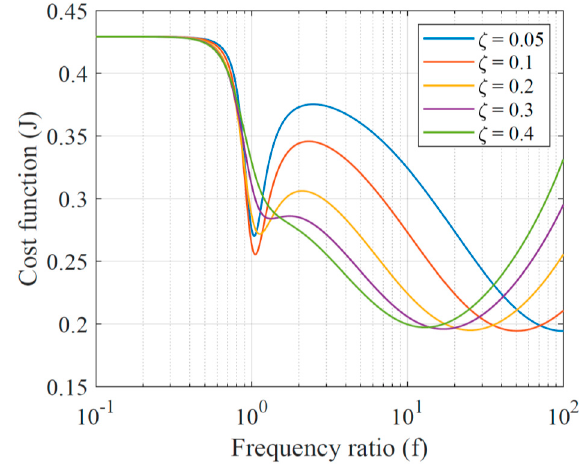
Figure 2. Variation of the cost function with frequency ratio and damping ratio of the TMD. Themass of the TMD is taken as 3% of the mass of building A in this example.